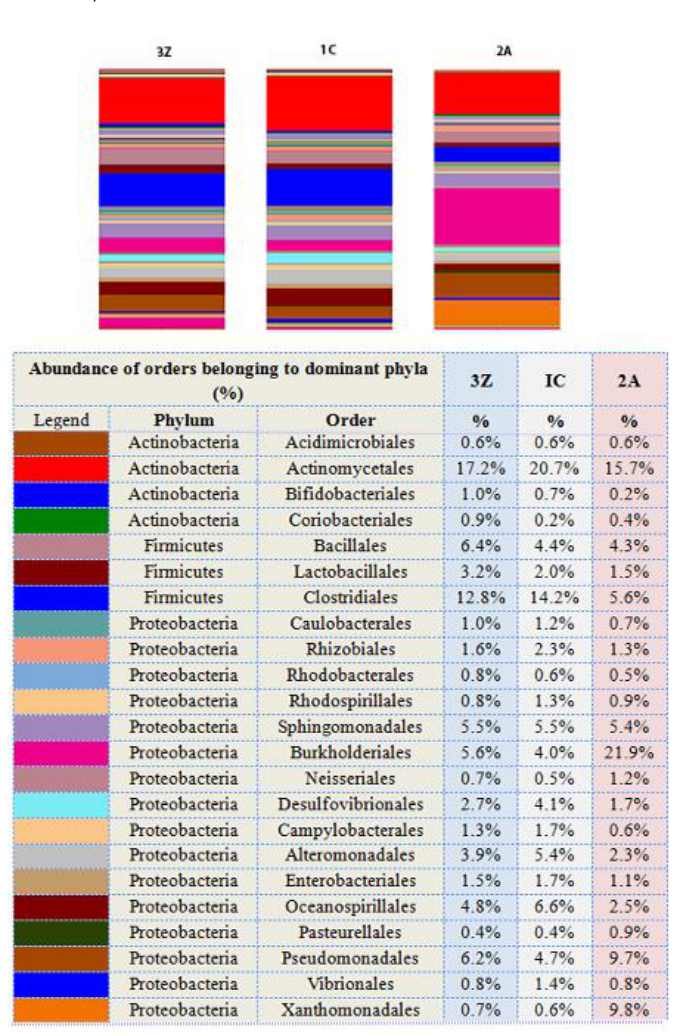
Figure 4. Relative abundance of bacterial orders of dominant phyla in treated and untreated soil samples. The figure and accompanying table indicate relative abundance (%) of bacterial orders belonging to only the three dominant phyla—Actinobacteria, Firmicutes, and Proteobacteria. The table also shows the phyla to which these orders belong. Since only the most dominant phyla have been presented at the order level, the total of percentages do not add up to 100. The orders have been chosen based on their relative abundance within the phylum and the most prominent ones have been tabulated. 1C—control (untreated soil); 2A—silver nanoparticle-treated soil; and 3Z—zinc oxide nanoparticle-treated